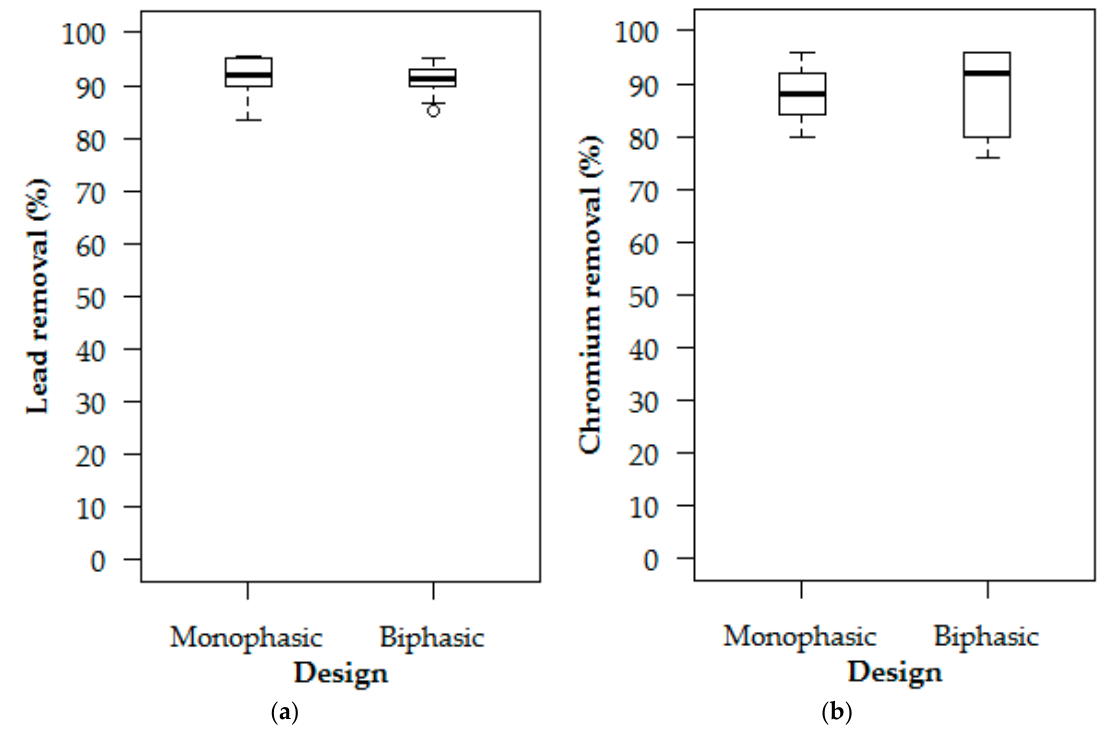
Figure 6. Suspended- or settled-phase heavy metal removal by design type: ( a ) lead; ( b ) chromium. “ o” indicates outlier.